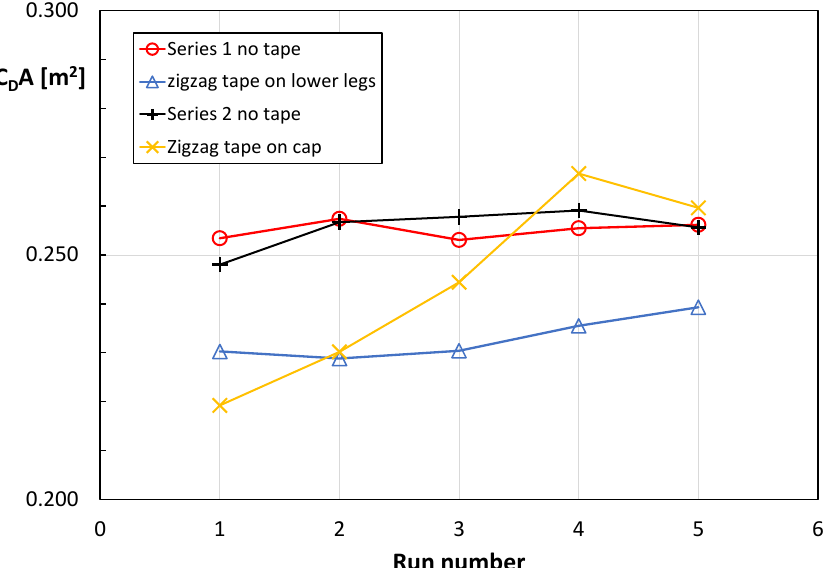
Figure 8. The effect of zigzag tape on the lower legs and cap of a male long-distance speed skater’s drag area at a wind speed of 12.1 m/s. R D = 0.8 × 10 5 (based on lower-leg average equivalent diameter). Tape at 55° equivalent azimuth angle for five sequential test runs. Table 1. Averages over five runs of the drag area C D A of three configurations showing the effect of 0.5 mm thick zigzag tape on lower legs and 0.75 mm on the cap.